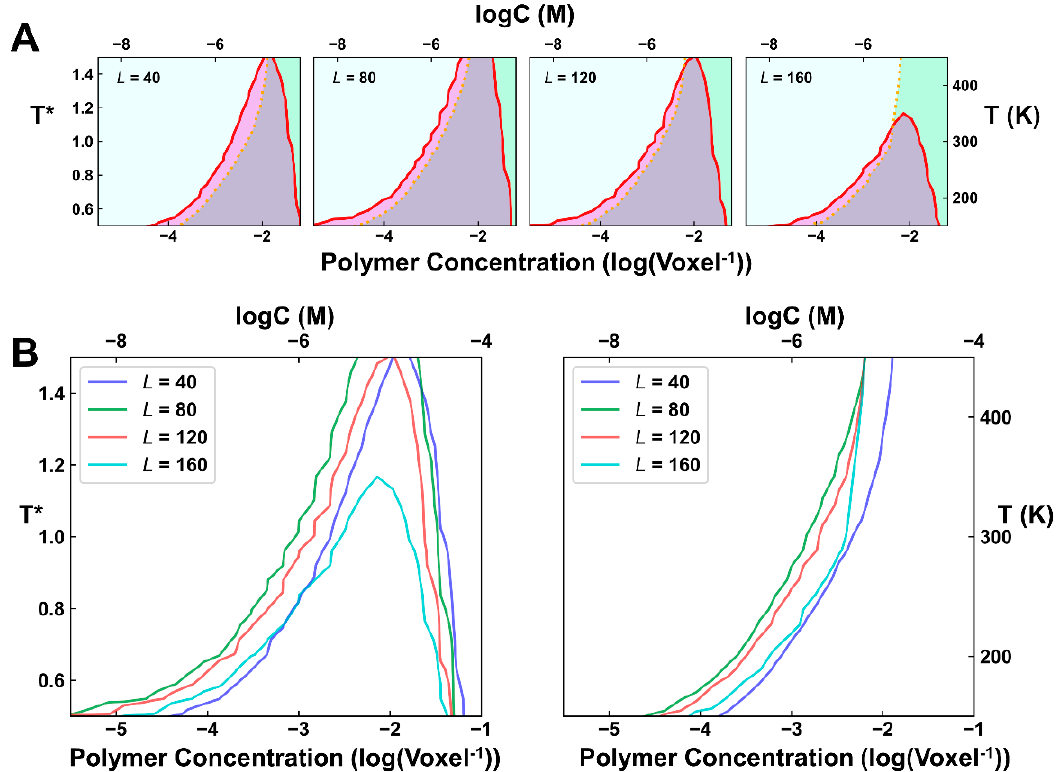
Figure 5. Phase behaviors for the systems with charged patches (a positively and a negatively charged patch) on the linker. ( A ) Phase diagrams of systems with different linker lengths. The used line and color scheme is the same as that in Figure 3. ( B , C ) Contour of ρ = 0.025 ( B ) and φ C = 0.5 ( C ) for different systems.